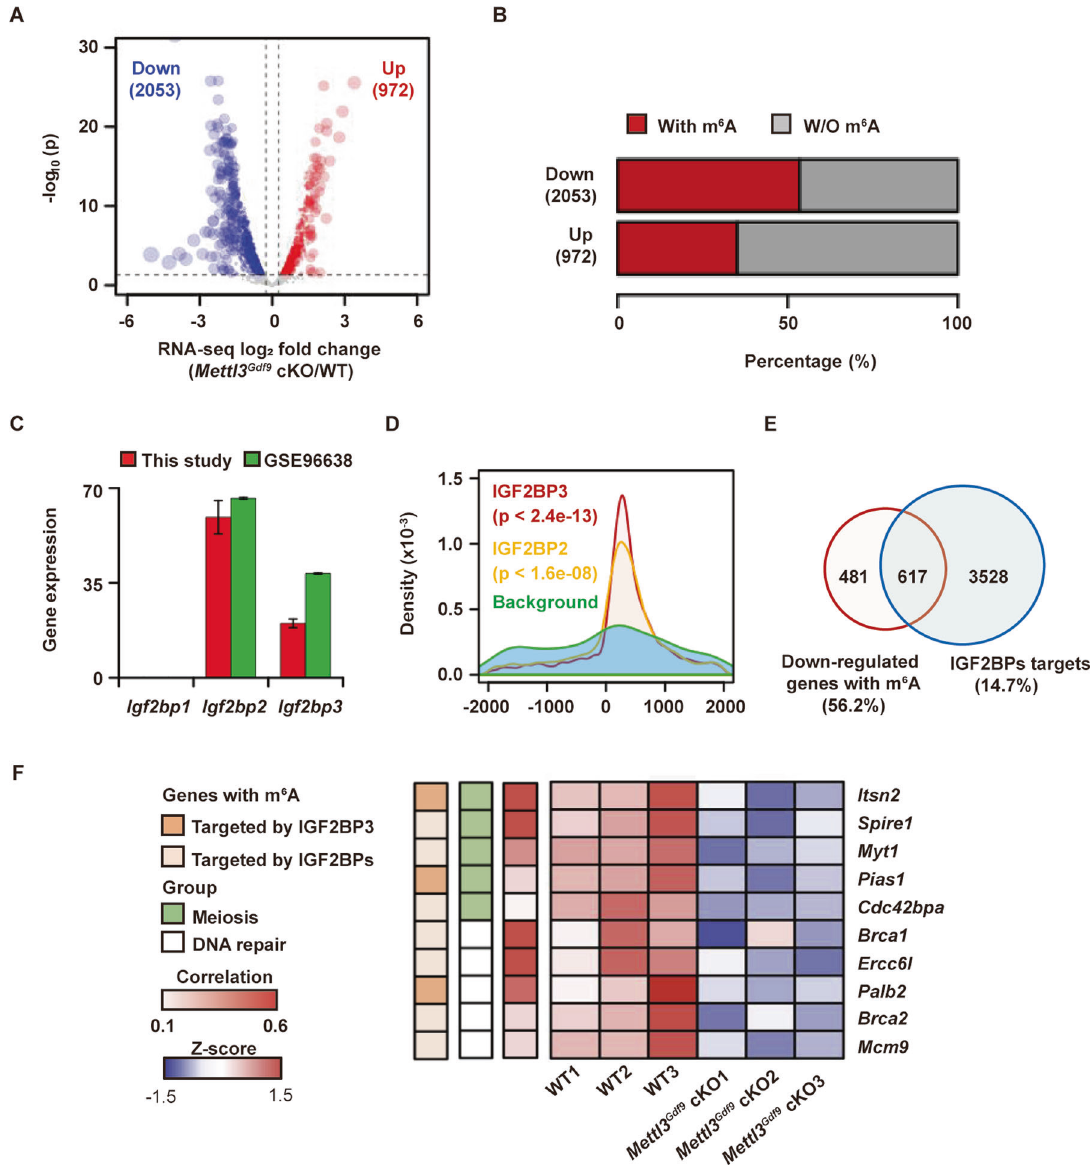
Fig. 5 METTL3-mediated m 6 A regulates RNA stability to affect oocyte maturation. A Volcano plot showing the expression differences for target transcripts under Mettl3 Gdf9 cKO. Transcripts with average RPKM values >3 in WT, |log 2 fold change| values > log 2 (1.2), and p values <0.05 as determined by DESeq2 were regarded as signi fi cantly dysregulated transcripts. The numbers of signi fi cantly downregulated (blue) and upregulated (red) transcripts are shown. The vertical dashed lines indicate the cutoff of |log 2 fold change| = |log 2 (1.2)|, and the horizontal dashed lines indicate the cutoff of p = 0.05. B Bar plot showing the ratios of transcripts with m 6 A modi fi cation among downregulated transcripts and upregulated transcripts under Mettl3 knockout. C Bar plot showing the expression of Igf2bp1, Igf2bp2 , and Igf2bp3 in GV oocytes, as determined by RNA-seq in this study and in the GSE96638 dataset. The data were shown as the mean ± SEM of two independent experiments for this study and 26 independent experiments for the GSE96638 dataset. D Density plot showing the distance between IGF2BP2/3 peaks identi fi ed by eCLIP (GSE78509) in hESCs and m 6 A peaks identi fi ed by MeRIP-seq in this study. The background was obtained by randomly shuf fl ing IGF2BP peaks using BEDTools ’ shuf fl eBed tool. The p value was determined by the two-sided Kolmogorov – Smirnov test. E Venn diagram showing the overlay between downregulated expressed transcripts with m 6 A peaks and IGF2BP2/3 target transcripts. F Heatmap displaying the transcript abundance in WT and Mettl3 Gdf9 cKO oocytes. Transcripts with m 6 A modi fi cations targeted by IGF2BPs are labeled brown, transcripts involved in meiosis or DNA repair are labeled in green or white, and the expression correlation between transcripts and Mettl3 is shown in